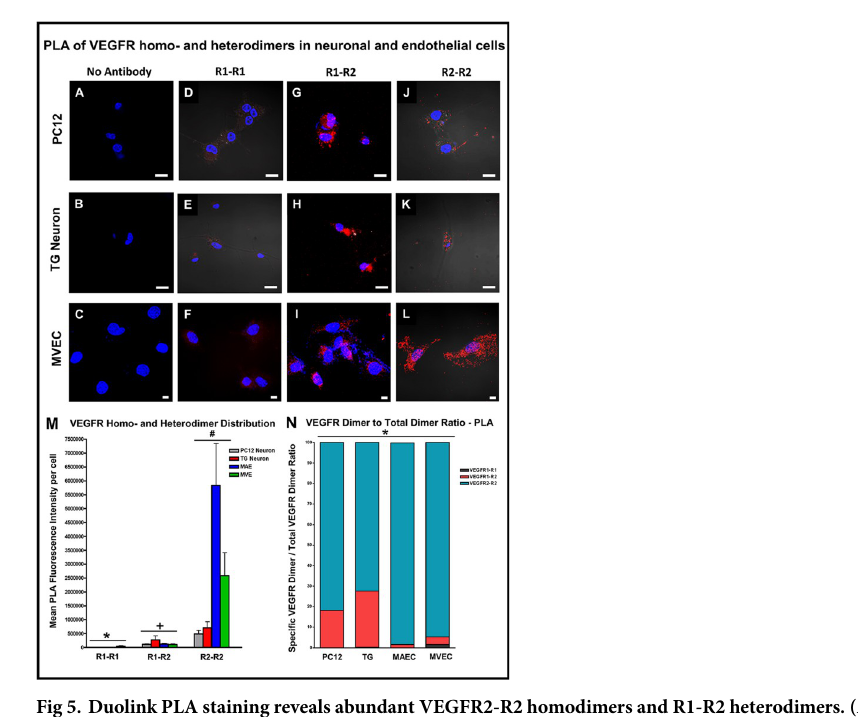
1.204 x 10 5 ± 2.053 x 10 4 ; MVEC: 9.9613 x 10 4 ± 2.4761 x 10 4 ; Mean ± SEM; n = 3; Fig 5G–5I). Duolink PLA staining for VEGFR1-R2 heterodimers showed distinct red fluorescent punctate staining indicating much higher levels of VEGFR1-R2 heterodimers as compared to R1-R1 homodimers in both neuronal (Fig 5G) and TG Neuronal (Fig 5H) as well as endothelial cells (Fig 5I). Duolink PLA staining for VEGFR2-R2 homodimers showed very bright discrete red fluorescent punctate spots of VEGFR2-R2 homodimers. Endothelial cells (Fig 5L) showed higher levels of VEGFR2-R2 homodimers as compared to PC12 neuronal cells (Fig 5J) and TG